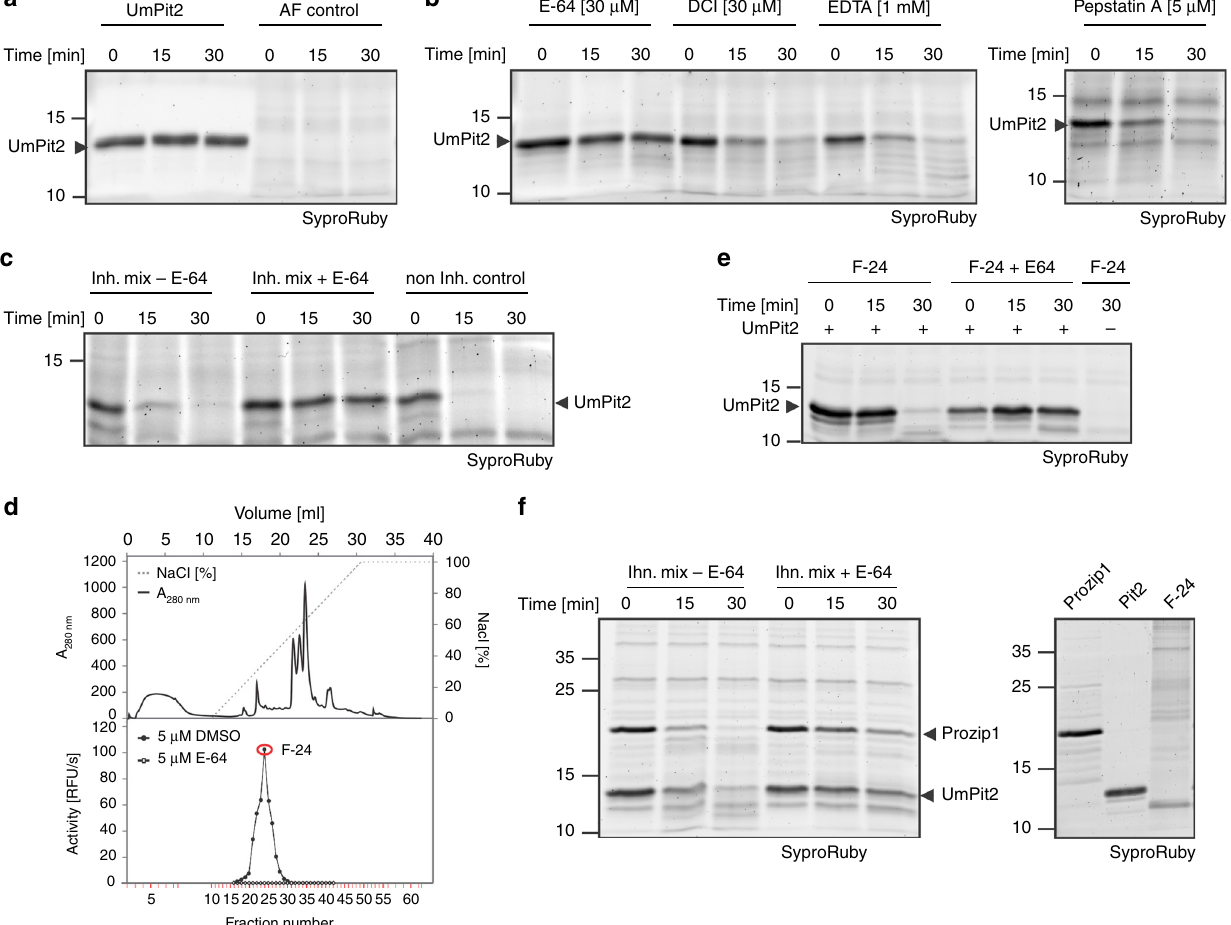
Fig. 5 PLCPs cleave UmPit2 in the apoplast. a Input used to perform inhibitory test of Pit2 stability. Heterologous expressed UmPit2 and maize AF at different time points during the experiment. b Addition of E-64 stabilizes Pit2 degradation. Four inhibitors for main classes of proteases: E-64 for cysteine proteases, DCI for serine hydrolases, EDTA for metalloproteases and Pepstatin A for aspartic proteases were preincubated with maize AF for 10 min. Pit2 degradation was analyzed over time (0, 15 and 30 min) using SyproRuby staining. c Inhibition of cysteine proteases stabilizes Pit2 in the apoplast. Maize AF was coincubated with a mix of inhibitors containing DCI [10 µ M], EDTA [1 mM] and Pepstatin A [10 µ M] (Inh. Mix) with or without E-64 [10 µ M]. As a control the noninhibitor sample containing DMSO is shown. d Fractionation of SA-treated apoplastic fl uid by anion-exchange chromatography. Top panel shows elution conditions and the pro fi le of eluted proteins using a salt gradient. Low panel shows PLCPs activity measurements of fractions with E-64 or DMSO as a control using the fl uoro-substrate Z-Phe-Arg-AMC. Fraction 24 (F-24, red labeled) showed the highest PLCP activity and was then used for further experiments. e PLCPs enrichment of F-24 cleaves Pit2. F-24 was preincubated with 10 µ M E-64 or DMSO followed by addition of puri fi ed UmPit2. Samples were incubated for 0, 15 and 30 min and analyzed by gel electrophoresis using SyproRuby. f UmPit2 is processed at similar rates as an endogenous maize substrate. UmPit2 as well as the endogenous maize PLCP substrate Prozip11 were heterologous expressed in E-coli . 3.2 µ M proteins were coincubated with F-24 pretreated with inhibitor mix (Inh. mix) in the presence or absence of E-64. Processing of Prozip11 and UmPit2 has been monitored over time. Samples were analyzed by gel electrophoresis and stained with SyproRuby for visualization. As a control puri fi ed proteins as well as F- 24 were loaded on gel (right gel). DMSO dimethyl sulfoxide, DCI 3,4-dichloroisocoumarin NATURE COMMUNICATIONS| (2019) 10:1576